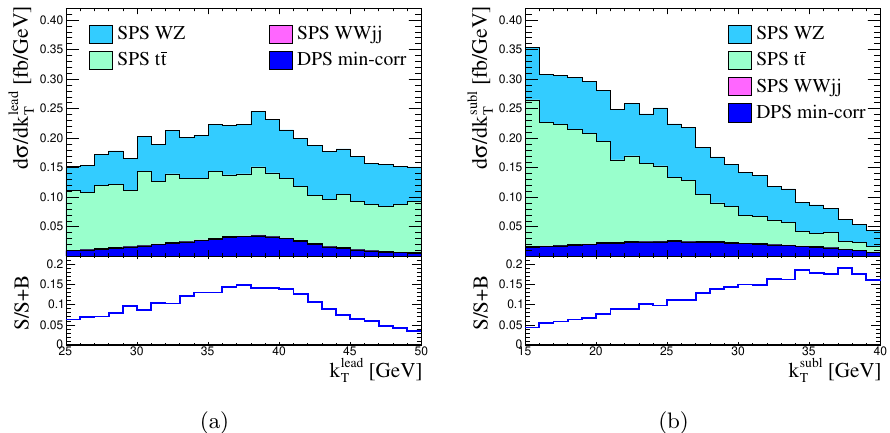
Figure 7 . The distributions of the transverse momentum of the leading (a) and sub-leading (b) muon. The relative contribution of the signal to the total yield is plotted underneath.